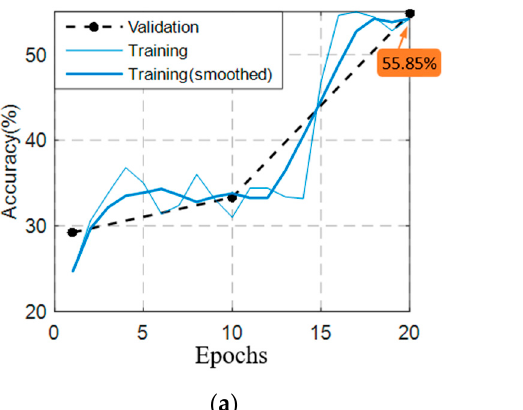
( b ) Figure 9. Comparison between DCNNs and Ada-DCNNs in 4 accuracy levels: ( a ) Accuracy of DCNNs as well as the increment by Ada-DCNN in 4 accuracy levels; ( b ) Difference of accuracy between DCNNs and related Ada-DCNNs in 4 accuracy levels. The results indicate that the diagnosis accuracy of Ada-DCNN is obviously higher than the related DCNN in all accuracy levels. Figure 9b shows the difference of accuracy between the DCNNs and related Ada-DCNNs. It can be seen that the improvement declines with the growing of DCNN accuracy from S1 to S4 for the three networks, which is not difficult to understand as the accuracy increases more slowly when it approaches the ceiling (100%). A further calculation shows that the average accuracy of DCNNs from S1 to S4 is improved by an absolute value of 15.37%, 12.29%,